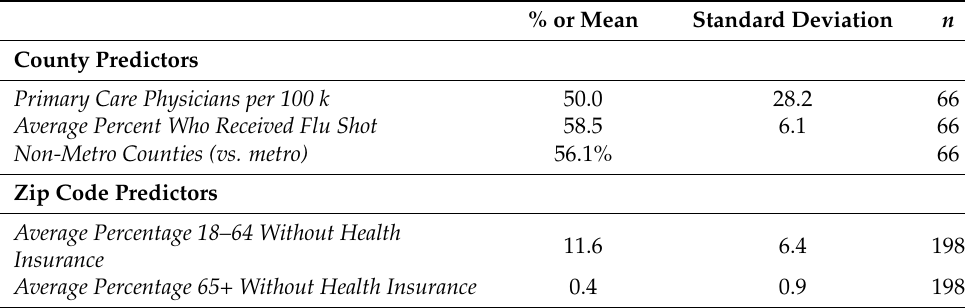
Table 3. County and Zip Code-Level Descriptive